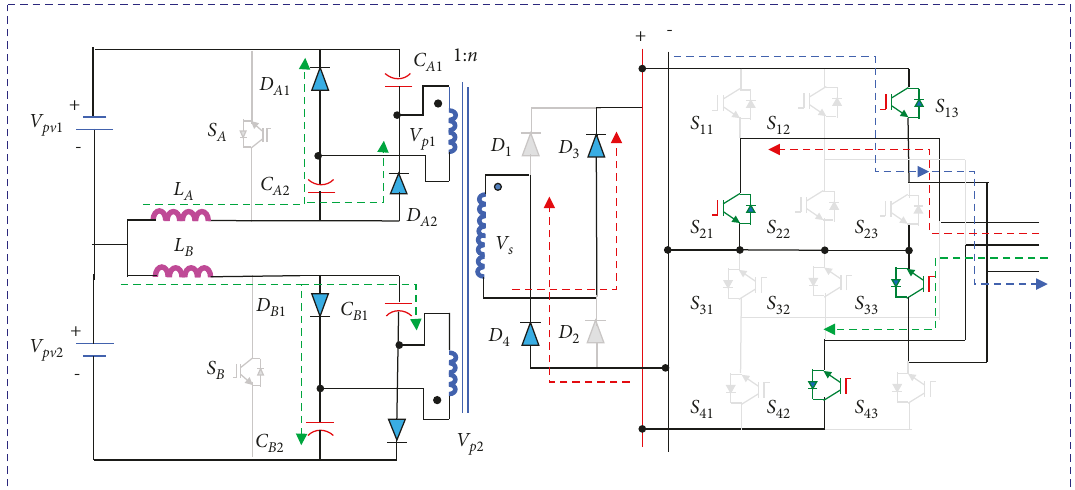
Figure 10: Equivalent circuit of mode 6